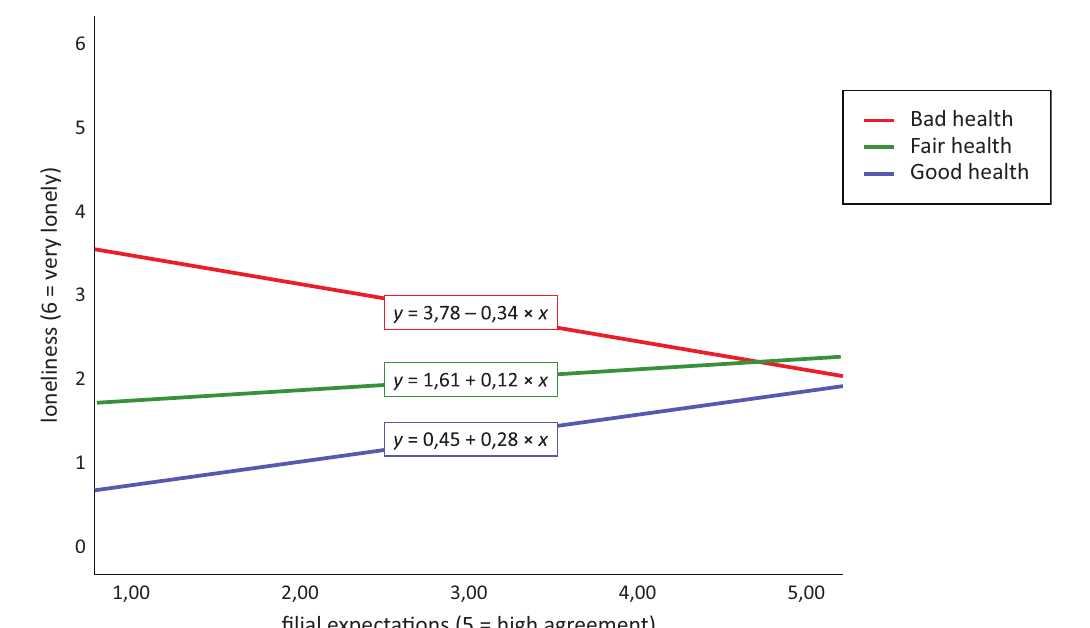
Figure 1. Interaction of observed values between loneliness and filial expectations for categories of perceived health. in Germany. In Germany, as well as in other European countries, migrants age alongside native